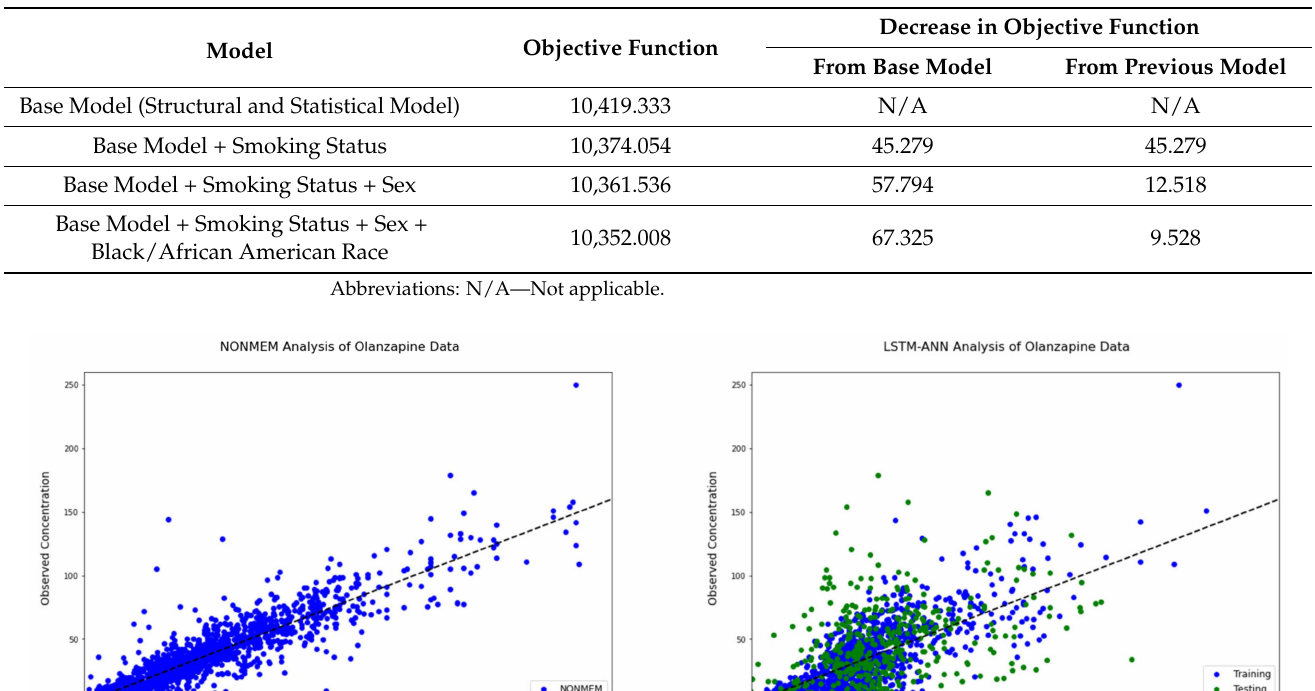
Table 3. Changes in objective function with the addition of influential covariates.